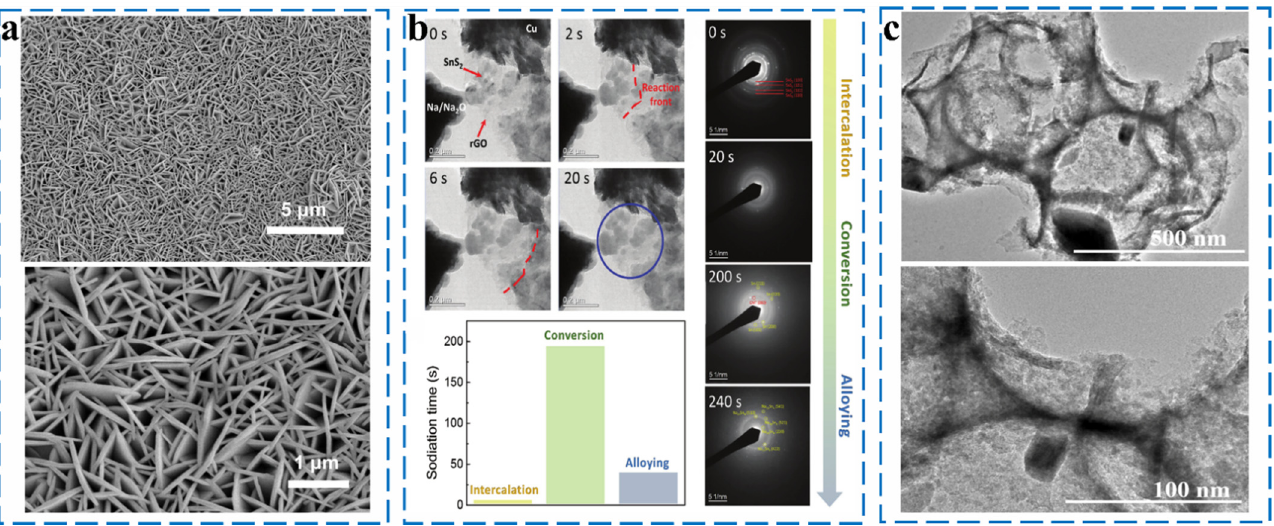
Figure 15. ( a ) SEM image of SnS 2 NWAs. Reprinted with permission from [97]. Copyright 2019 copyright Lu, S. ( b ) Sequential TEM images of Na intercalation into the SnS 2 /GCA electrode taken from the high-speed video and SAED patterns taken at different sodiation stages and durations required to complete intercalation, conversion, and alloying reactions during the in situ sodiation process. Reprinted with permission from [98]. Copyright 2019 copyright He, Y. ( c ) Low and high-resolution TEM images of the 1.5–350 3D SnS/C composite. Reprinted with permission from [99]. Copyright 2021 copyright Sun, Y.